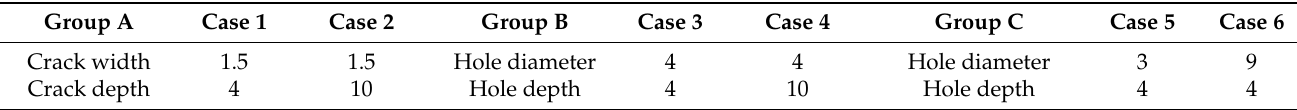
Table 1. Test circumstances of specimens for three